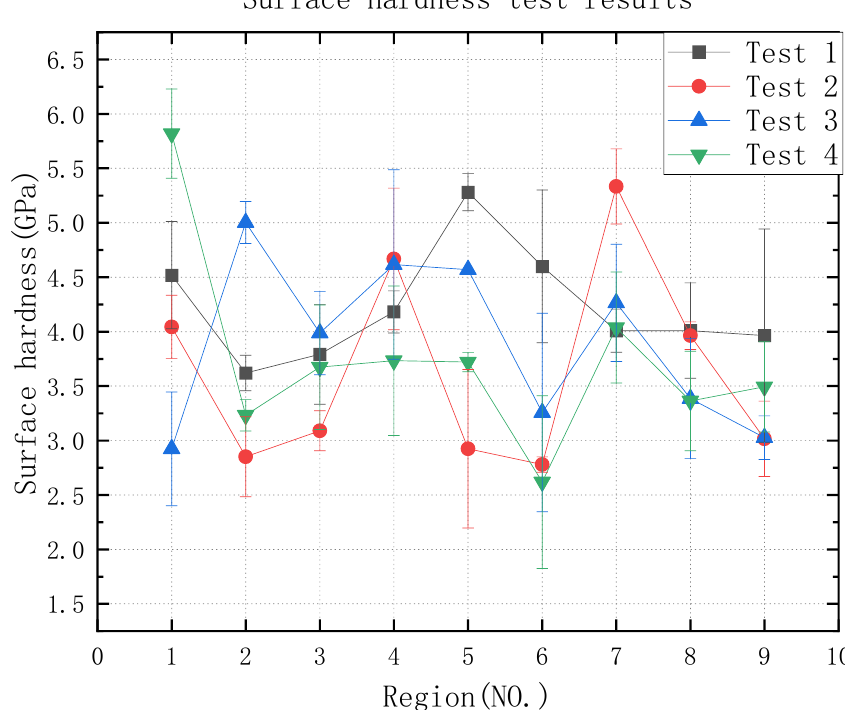
Figure 8. Graph of surface hardness test results.